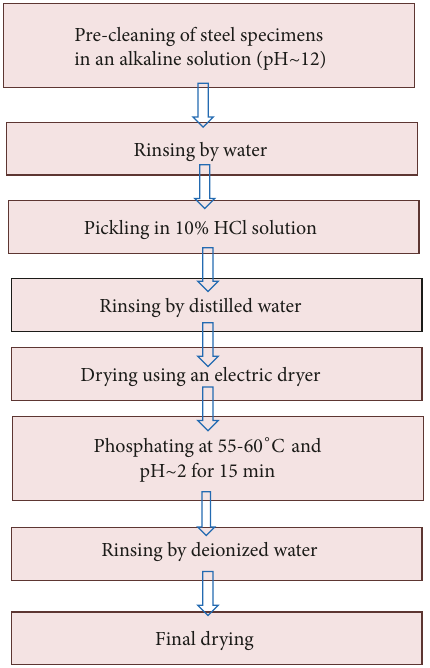
Figure 1: A schematic representation of the full steps of phosphating